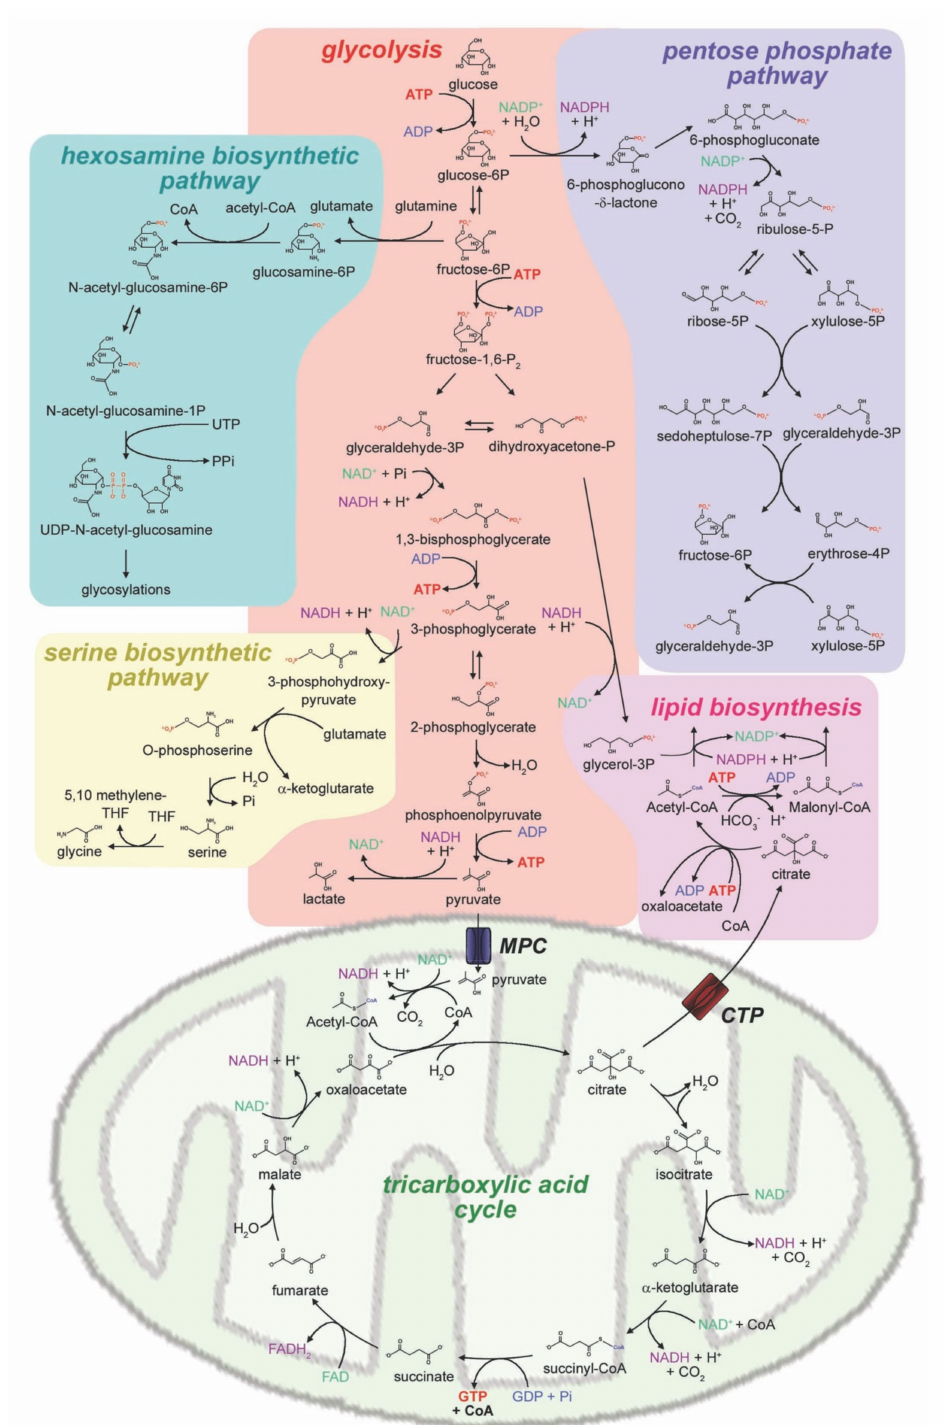
Figure 1. Metabolic pathways of glucose utilization in cancer